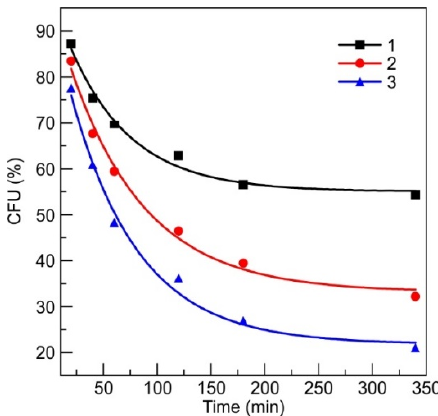
Figure 4. The evolution of antimicrobial activity of silver ion (Ag + ) rich water of different Ag concentration: “1”—(1 ppm), “2”—(3 ppm), “3”—(4 ppm) in concentration. The fit parameters of the exponential functions are provided in Supplementary Table S2.